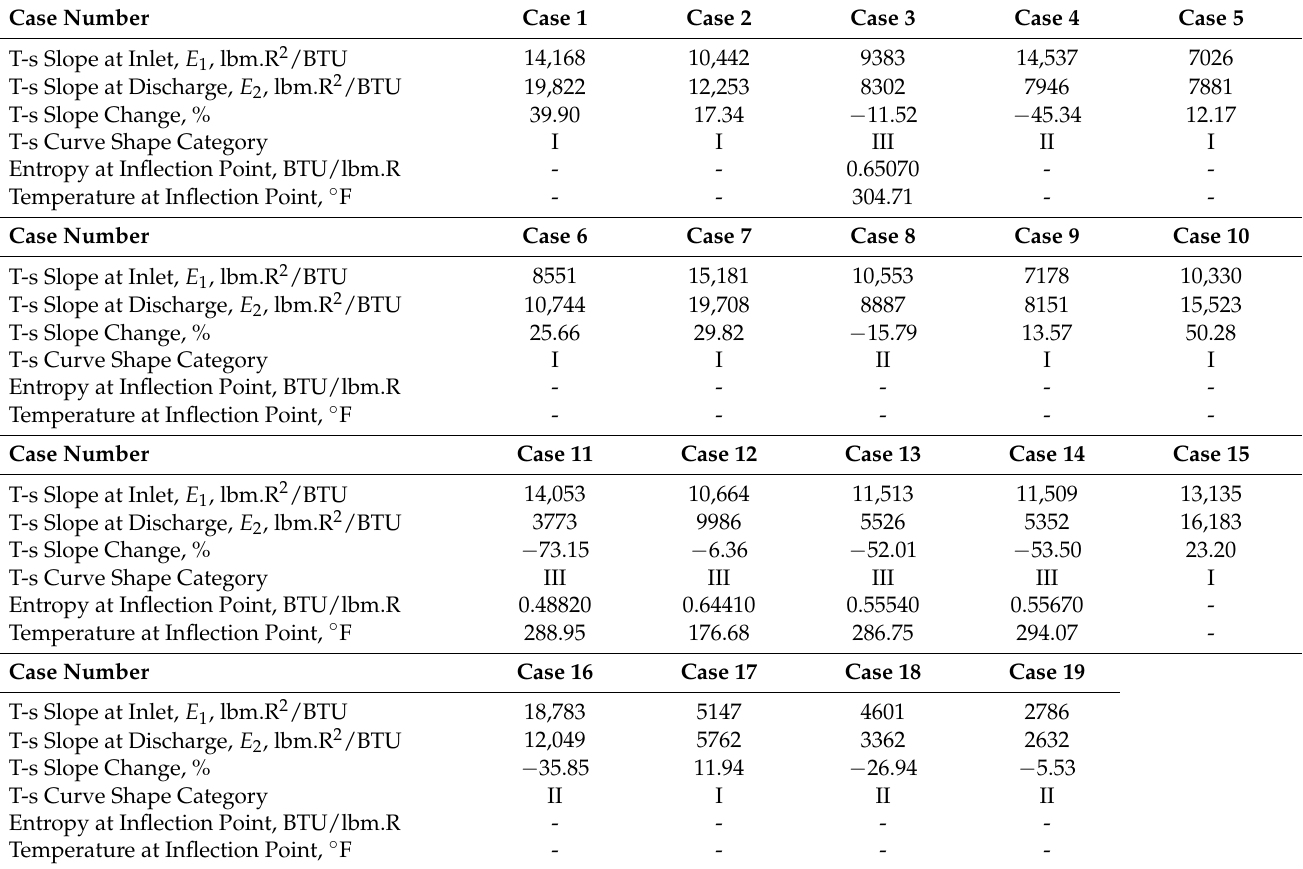
Table A2. Taher–Evans Cubic Polynomial endpoint method T-s path slope and